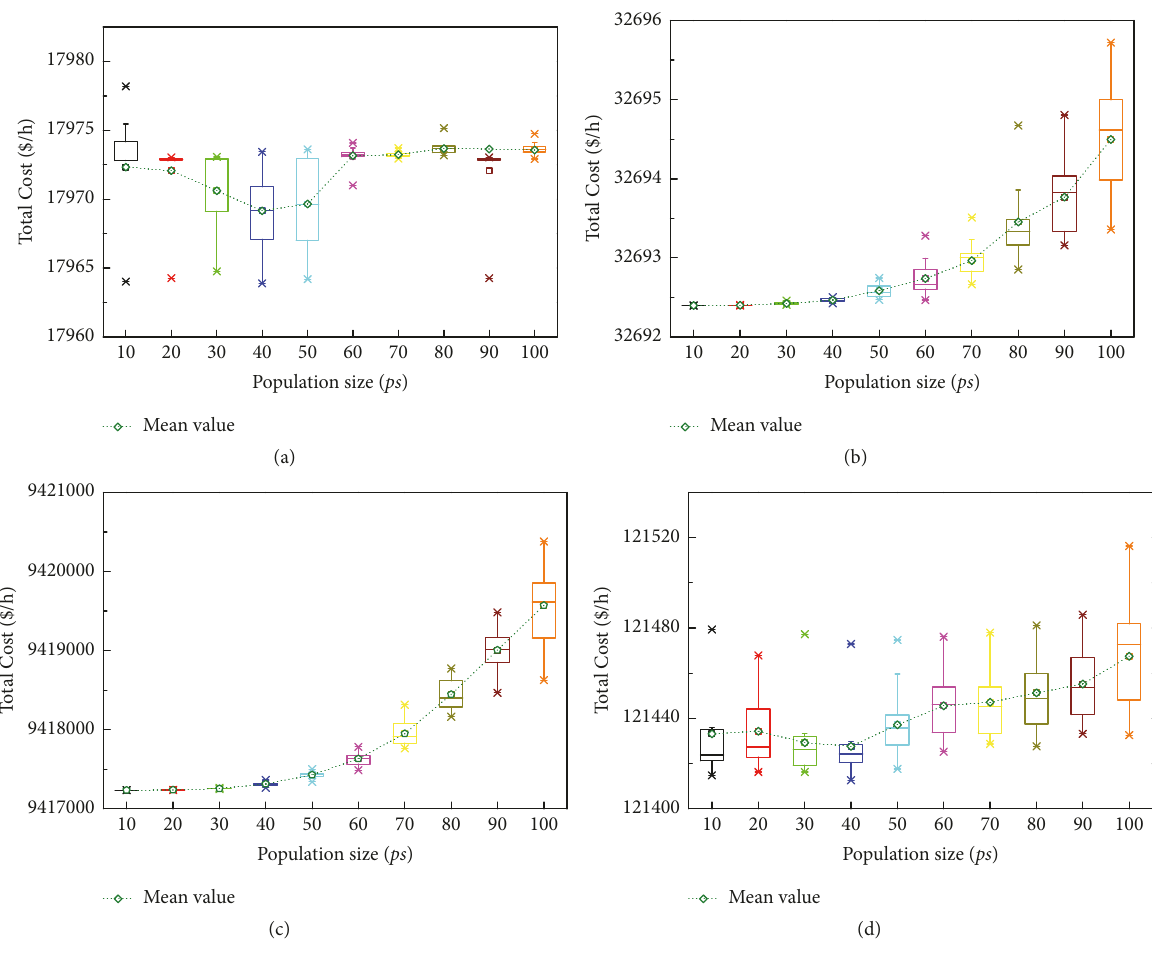
Figure 6: Influence of population size. (a) Case I. (b) Case II. (c) Case III. (d) Case